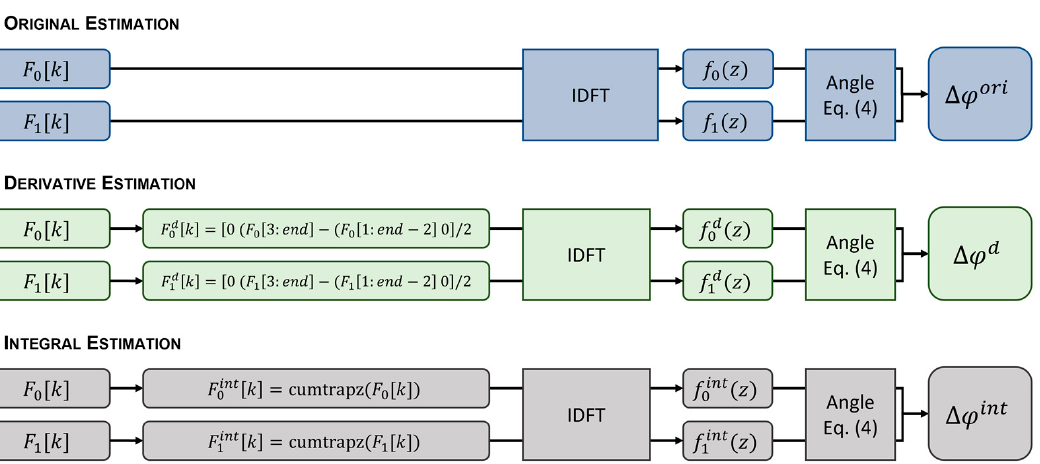
Figure 3. Workflow diagram showing the phase difference estimation from the original interferogram ( A ), the first-order derivative ( B ), and the integral of the original interferogram ( C ). Equation (4): ∆ ϕ [ z ] = tan − 1 (( Im { f } Re { f } − Re { f } Im { f } ) / ( Re { f } Re { f } + Im { f } Im { f } )) 0 0 0 0 1 1 1 1